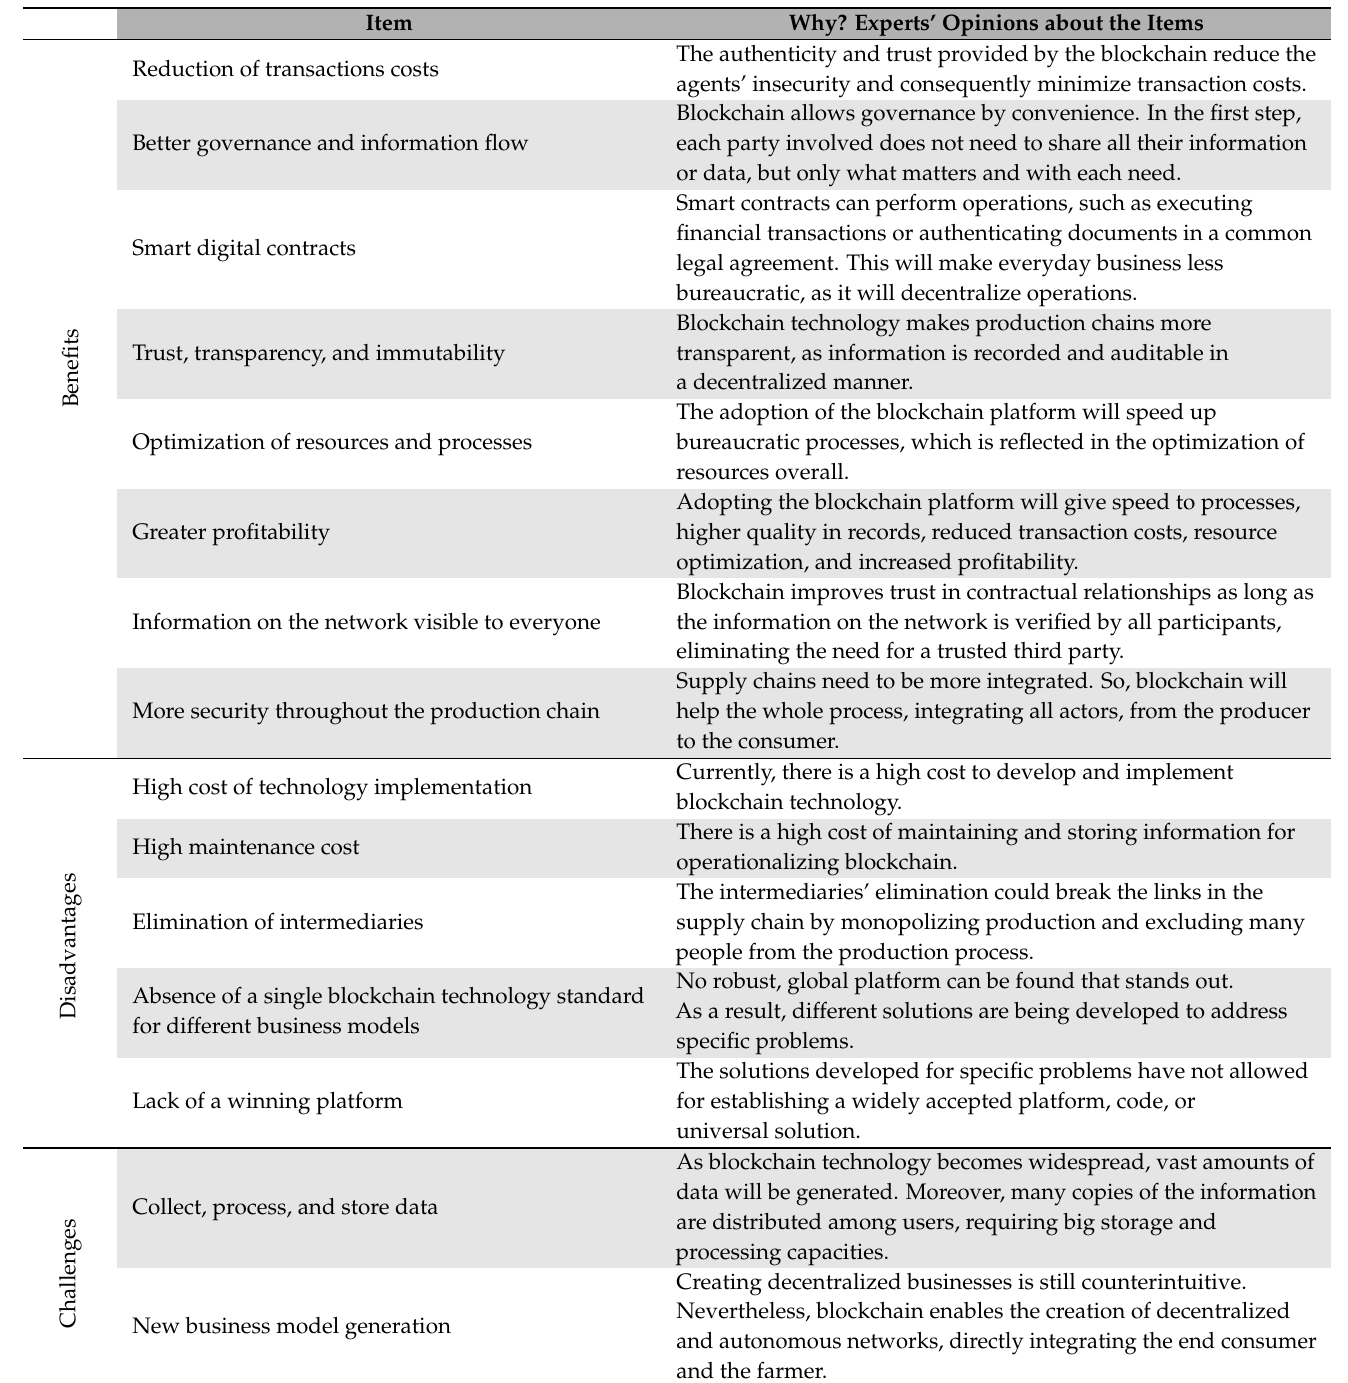
Table 2. Experts’ opinions about the benefits, disadvantages, challenges, and opportunities of blockchain